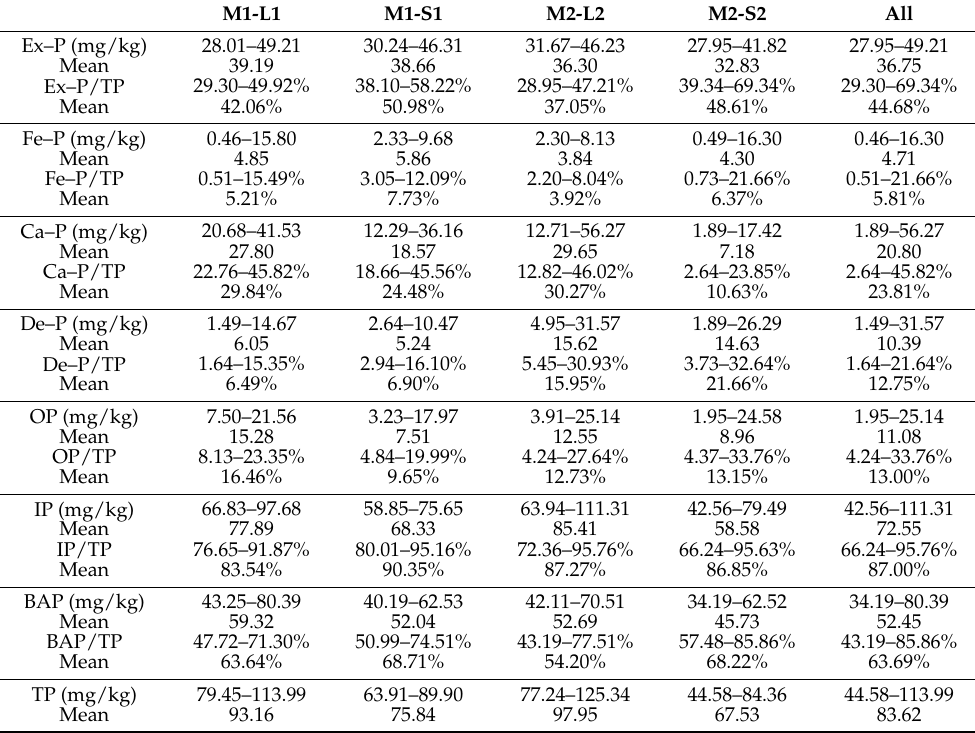
Table 2. Ranges and mean, and percentage ranges and mean, of each sediment P to